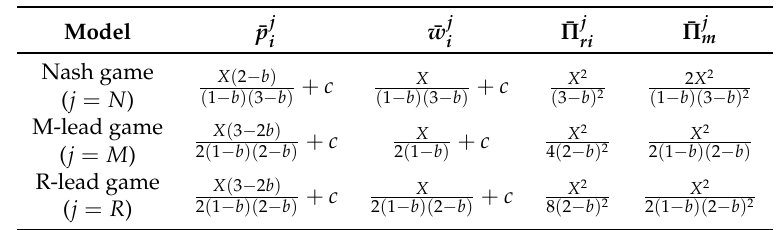
Table 3. Optimal decisions and profits in no investment